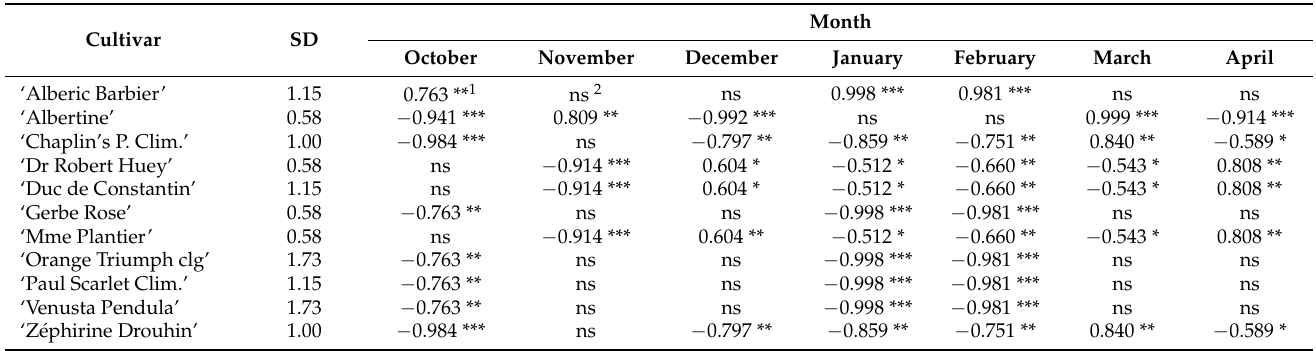
Table 3. The effect of correlations between frost damage of climber roses and average monthly air temperature (2005/2006, 2009/2010, and 2015/2016).